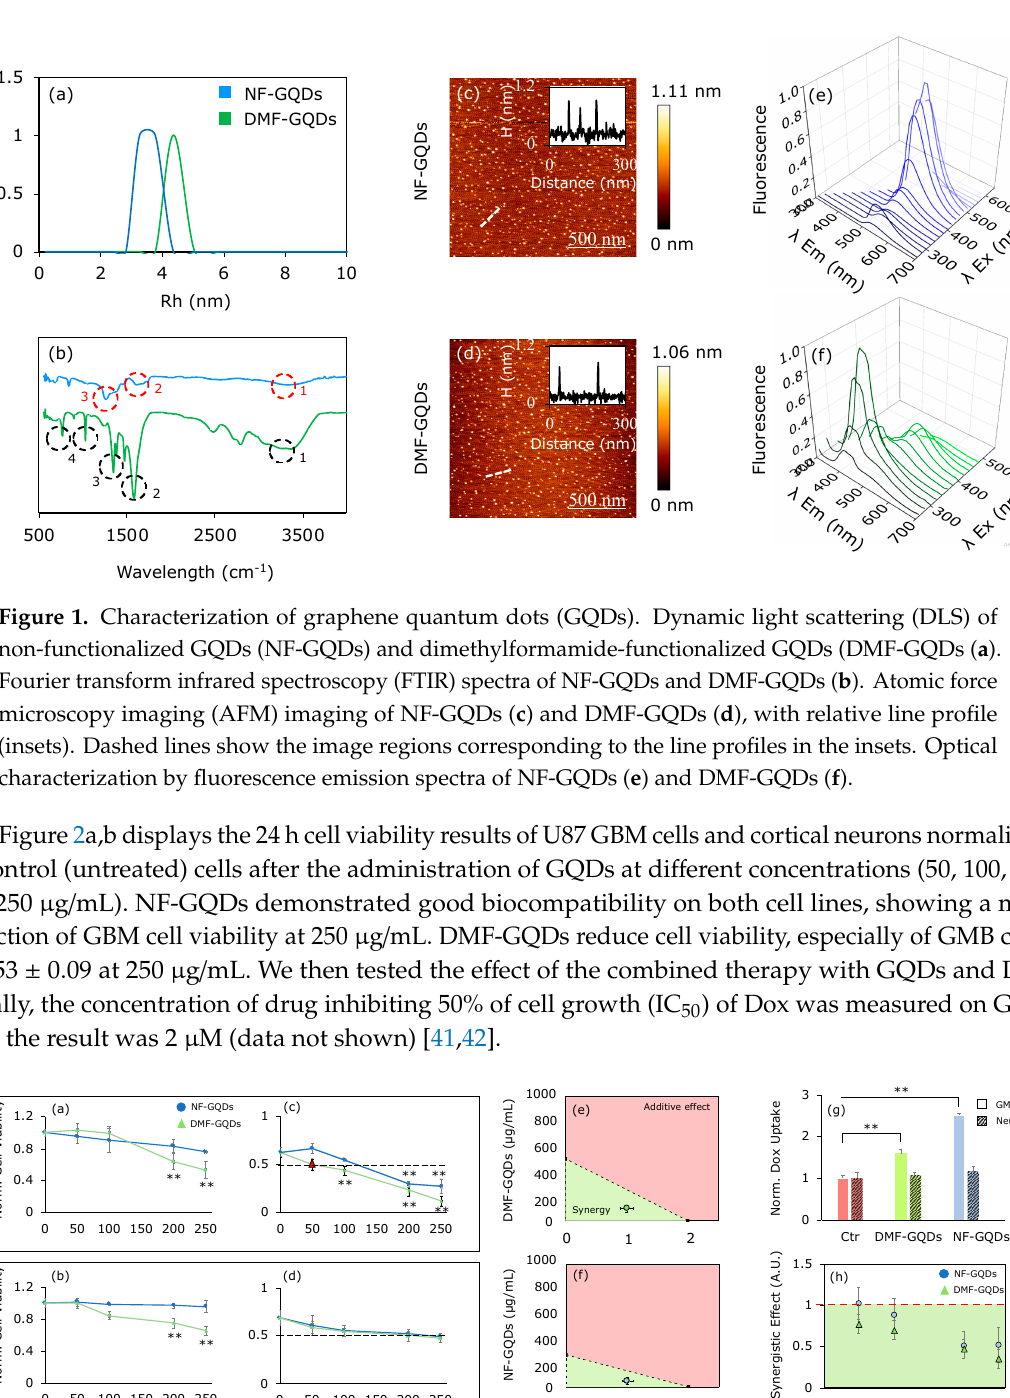
Fourier transform infrared spectroscopy (FTIR) spectra of NF-GQDs and DMF-GQDs ( b ). Atomic force microscopy imaging (AFM) imaging of NF-GQDs ( c ) and DMF-GQDs ( d ), with relative line profile (insets). Dashed lines show the image regions corresponding to the line profiles in the insets. Optical characterization by fluorescence emission spectra of NF-GQDs ( e ) and DMF-GQDs ( f ).